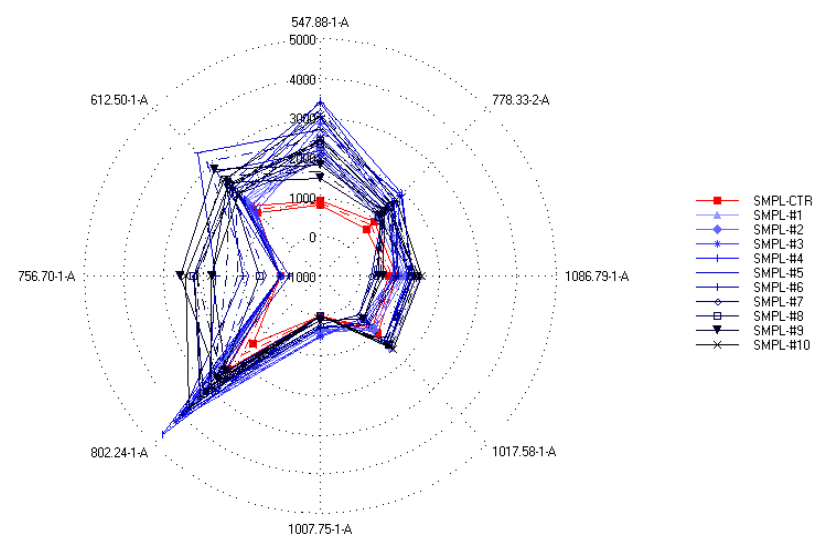
Figure 5. Y-fit of the PLSR calibration on the S17-P100 concentration (mg/in 10 g product) using data from all sensors (R 2 : determination coefficient; SEC: standard error of calibration; #LV: number of latent variables); the intensity of the colors from light blue to black along the Y-fit line represents the increase in concentration levels of the DHA supplementation.